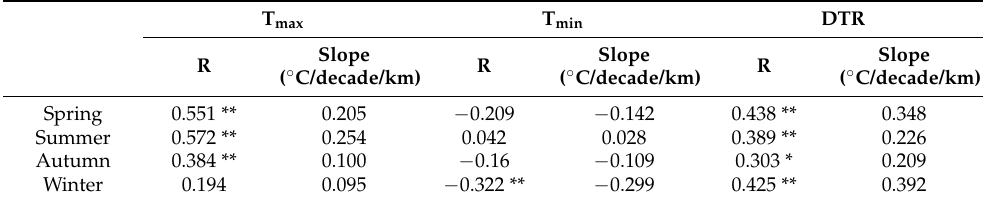
Table 3. Relationships between elevation and the T max , T min , and DTR trends in northeast China. “R” represents the correlation coefficient, while“slope” represents the altitude gradient of temperature. T max T min DTR Slope Slope Slope R R R ( ◦ C/decade/km) ( ◦ C/decade/km) ( ◦ C/decade/km) Spring 0.551 ** 0.205 − 0.209 − 0.142 0.438 ** 0.348 Summer 0.572 ** 0.254 0.042 0.028 0.389 ** 0.226 Autumn 0.384 ** 0.100 − 0.16 − 0.109 0.303 * 0.209 Winter 0.194 0.095 − 0.322 ** − 0.299 0.425 **